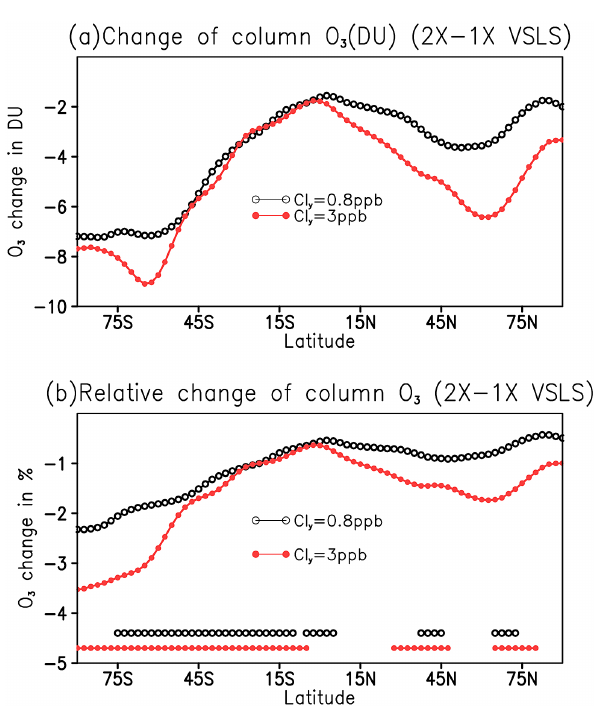
Figure 4. Latitude distributions of annual mean total ozone changes due to a doubling of VSLS. The top panel (a) shows the absolute changes in Dobson units, and the bottom panel (b) shows the rel- ative changes in %. Each line represents one particular Cl y level (black open circles: Cl y = 0.8ppb; red closed circles: Cl y = 3ppb). Note that we average the ozone difference over the three different Br y concentrations for each Cl y case. The corresponding horizon- tal lines indicate where the differences are significant in each of the three pairs of integrations above a confidence level of 99% as cal- culated by student’s t